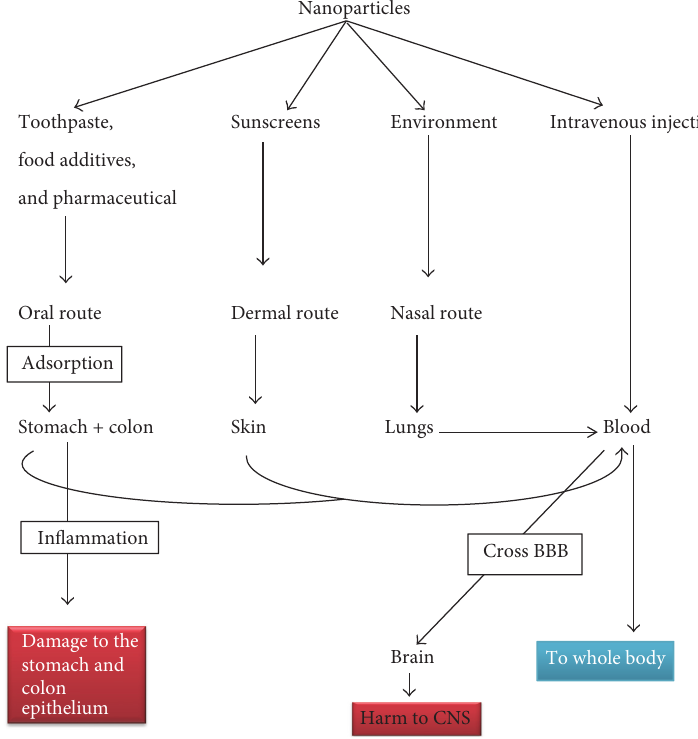
Figure 1: Nanoparticles containing products and their entrance ways into the biological